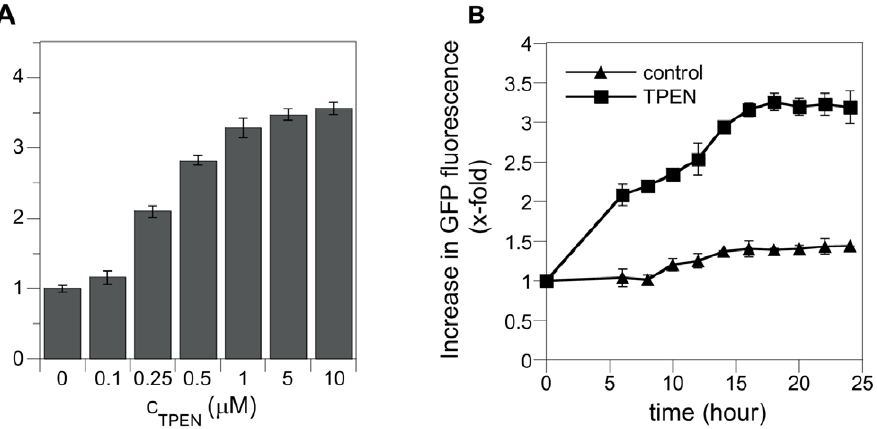
Figure 3. Dose and time response of GFP fluorescence after treatment with TPEN. A) Cells transformed with the ZRE-GFP promoter- reporter construct were grown in RPMI-1640 medium with indicated TPEN concentrations for 20 hours at 30 u C. Fluorescence signal was normalized by cell density and is expressed as x-fold increase of untreated sample. B) Cells containing the ZRE-GFP promoter-reporter construct were grown in absence or presence of 5 m M TPEN in RPMI-1640 medium at 30 u C. Fluorescence and cell density were measured at times indicated. Fluorescence signal is expressed as x-fold increase of the 0 hour time point. Error bars represent standard deviation (SD).